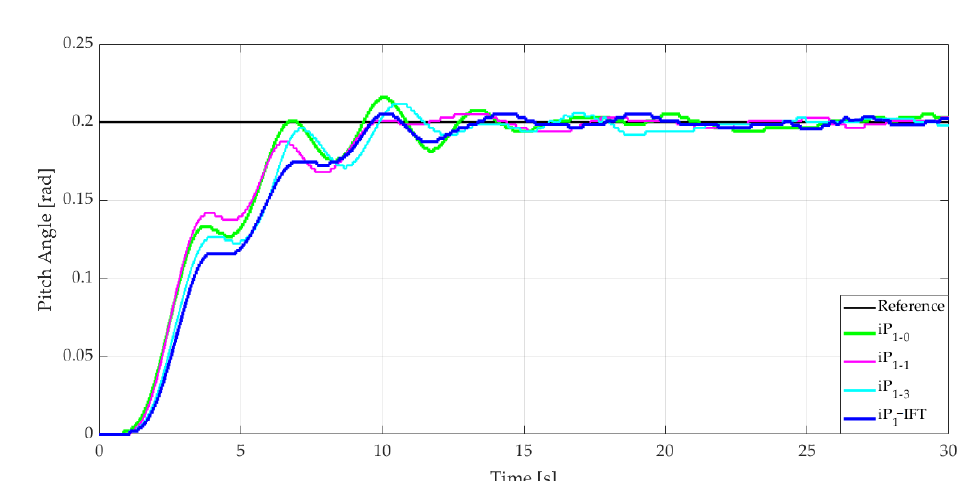
Table 2. Tuning parameters for the iP 1 controllers and the ITAE criteria values. pitch axis. The result of the comparison is depicted in Figure 6, from which the good Iteration Initial Values behavior of the iP 1 -IFT controller in relation to iP 1-0 is